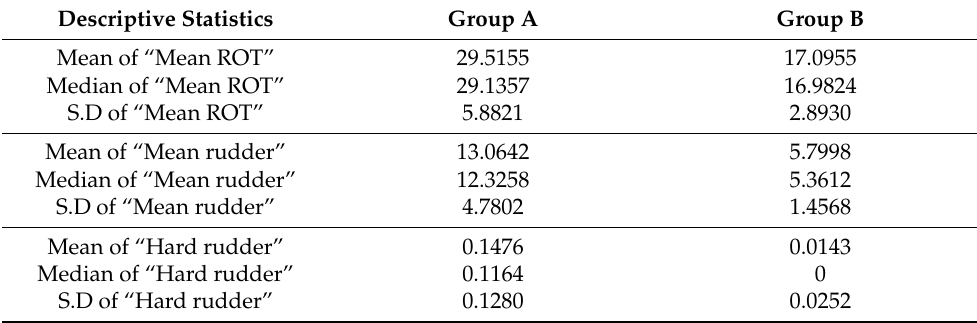
Table 4. Descriptive statistics for comparative